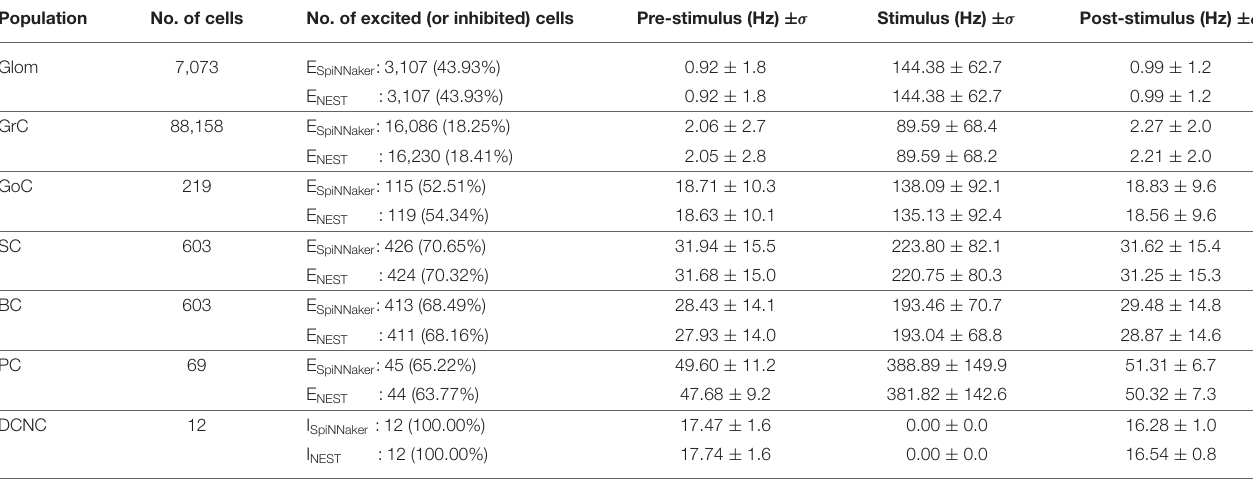
TABLE 5 | Filtered firing rates for each population in a single experimental trial. Population No. of cells No. of excited (or inhibited) cells Pre-stimulus (Hz) ± σ Stimulus (Hz) ± σ Post-stimulus (Hz) ± σ